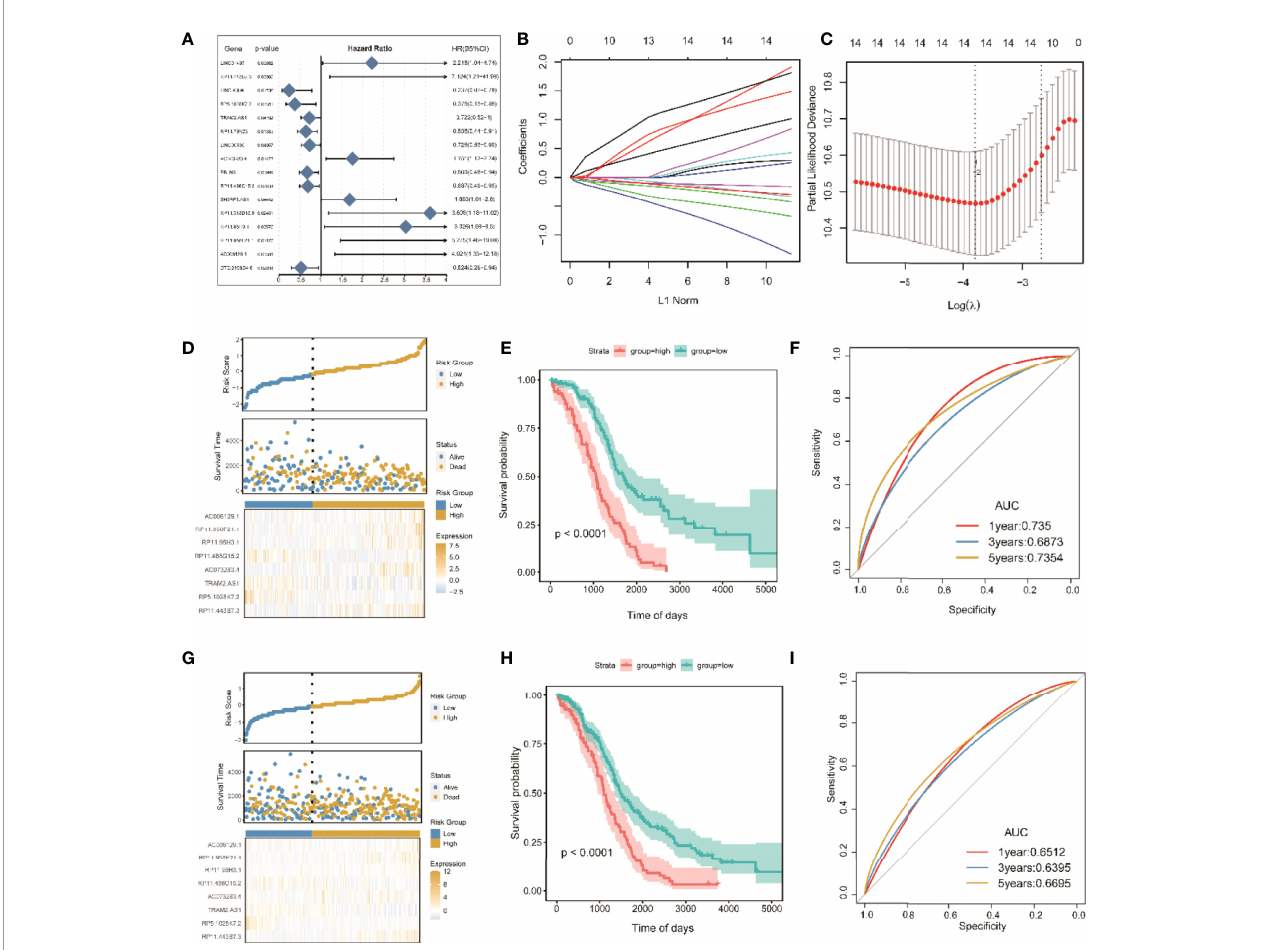
FIGURE 7 | Screening of signi fi cant LncRNAs in OC and construction of its risk score model. (A) Forest plots of single-factor Cox analysis; (B) change trajectory of each independent variable, the horizontal axis represents the log value of the independent variable lambda (the vertical axis represents the coef fi cient of the independent variable); (C) con fi dence interval under each lambda; (D) risk distribution map of the risk score in the training set; (E) survival curves of risk score in the training set; (F) ROC curves of risk score in the training set; (G) distribution map of risk score in all sets. (H) risk score survival curve in the total set; (I) ROC curve of risk score in total